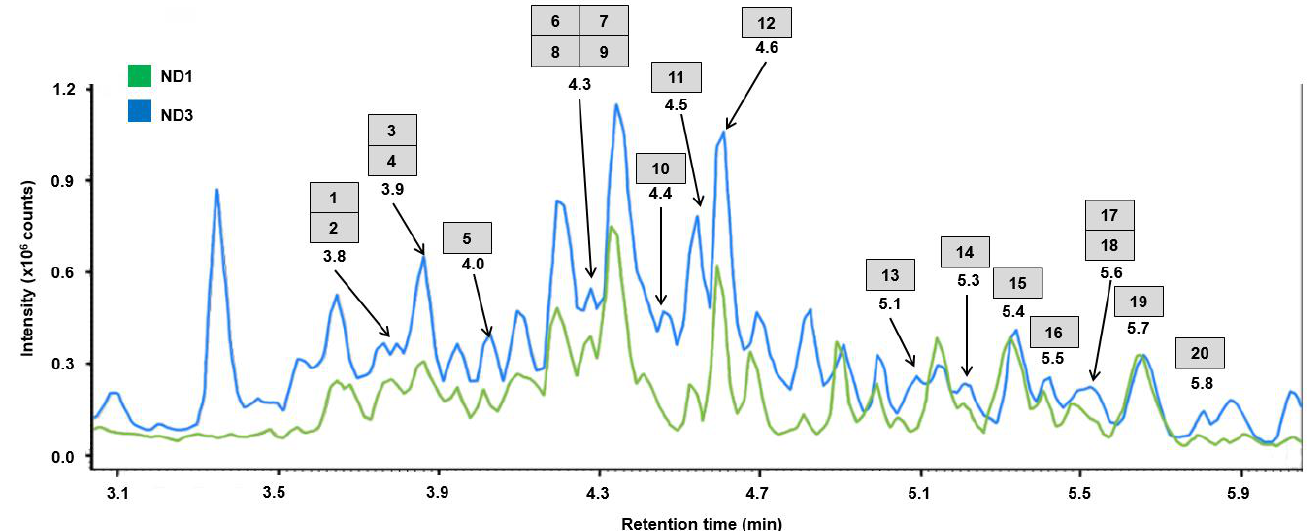
Figure 1. Total ion chromatograms (TICs) of the whole root extracts of A. elata prepared with the NADES, with the mixture of choline chloride and malic acid being 1:1 (ND1: green) and the mix- ture of choline chloride and lactic acid being 1:3 (ND3: blue). The analytes are listed as in Table 1.